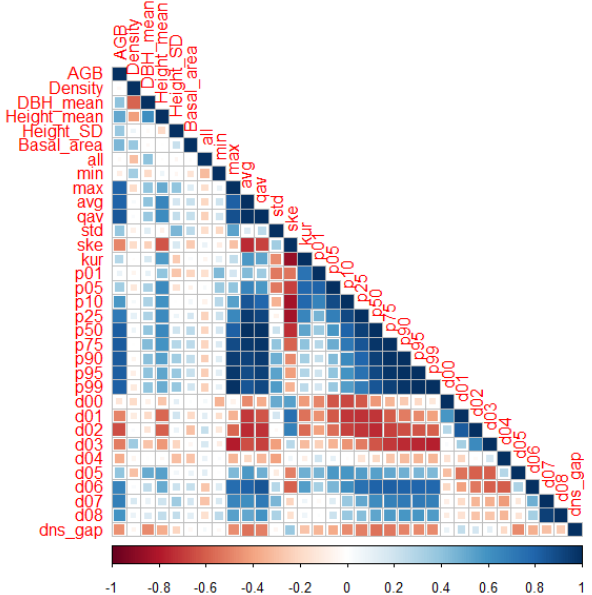
Figure 4. Correlation between structural parameters and the lidar metrics for 34 field plots scattered over the mangrove area inside the APA Guapimirim and ESEC Guanabara. The AGB used is computed using species-specific allometric equations.